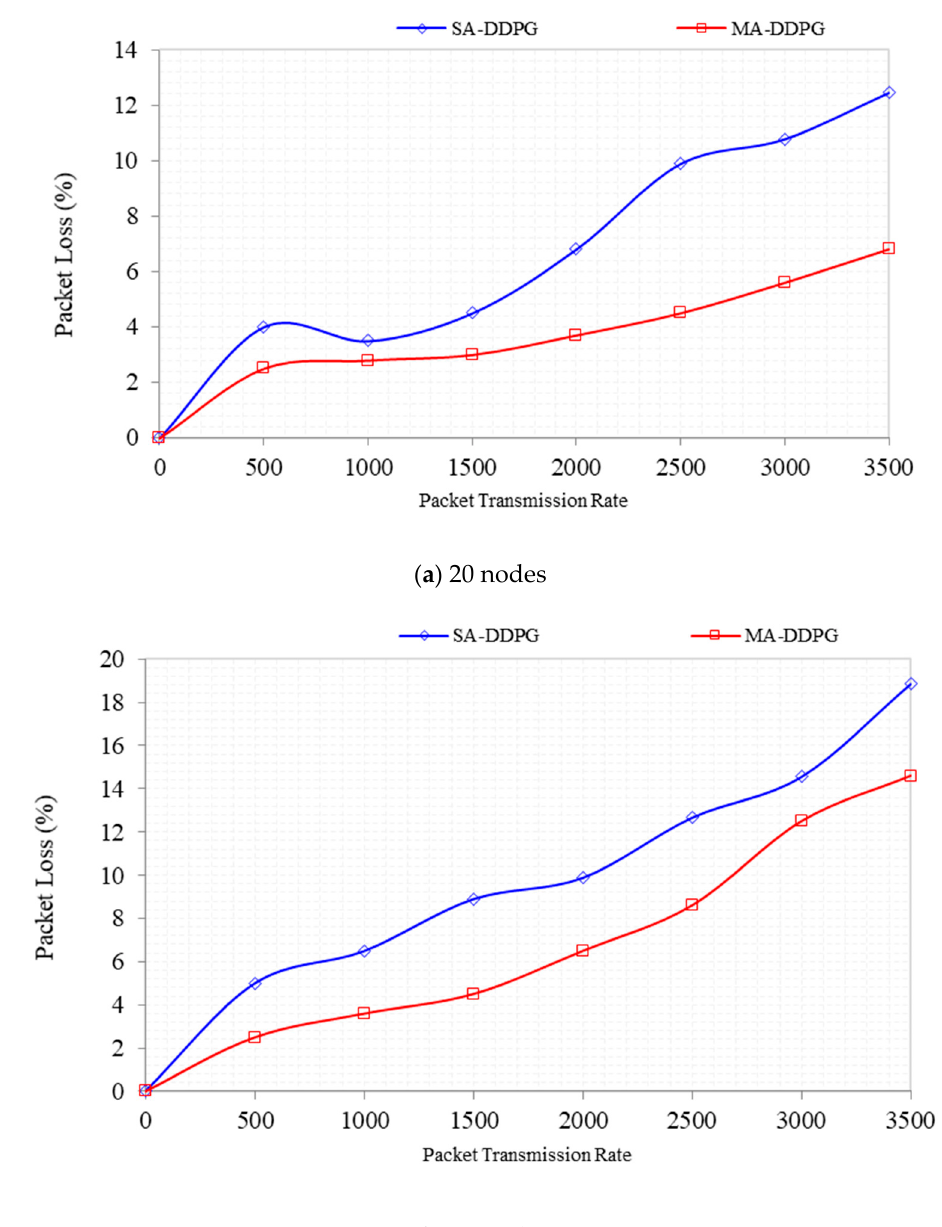
Figure 13. Packet loss vs. packet transmission rate for SA-DDPG and